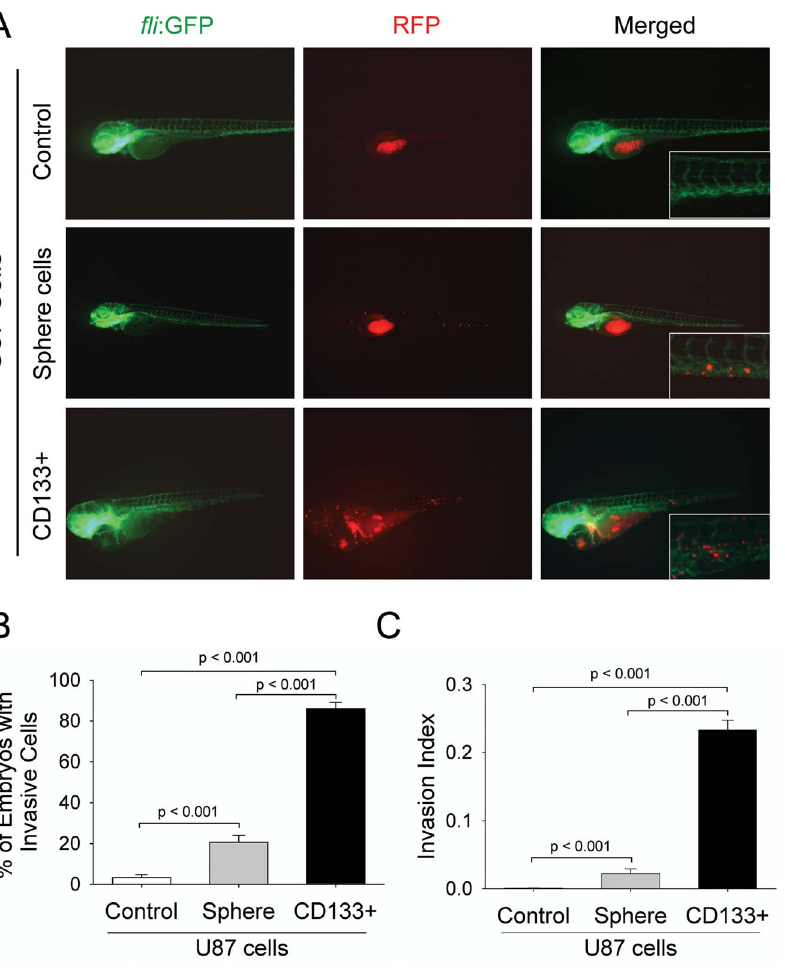
Figure 3. CD133 + U87 GSCs are highly invasive within zebrafish embryos. A. Representative images of the invasion of differentiated U87 cells, U87 sphere cells, and CD133 + U87 GSCs within the injected embryos at 2 dpi. The images at higher magnification show the invasive RFP-labeled cell masses at tail region of embryos via host vessels. B. The percentage of the embryos with invasive cells injected with RFP-labeled differentiated U87 cells, U87 sphere cells, and CD133 + U87 GSCs. The data were obtained from three replicate experiments of 50 injected embryos in each experiment: n=124 for live embryos injected with differentiated U87 cells, n=121 for embryos injected with U87 sphere cells, and n=120 for embryos injected with CD133 + cells C. The percentage of invasive cells within total injected cells (Invasion Index) in the embryos. All injected cells including invasive or non-invasive cells within zebrafish embryos were evaluated by ImageJ software through fluorescence intensity. n=37200 (300 injected cells per embryo among 124 live embryos) for differentiated U87 cell group, n=36300 (300 injected cells per embryo among 121 live embryos) for U87 sphere cell group, and n=36000 (300 cells per embryo among 120 live embryos) for CD133 + U87 GSCs group ( p , 0.001).